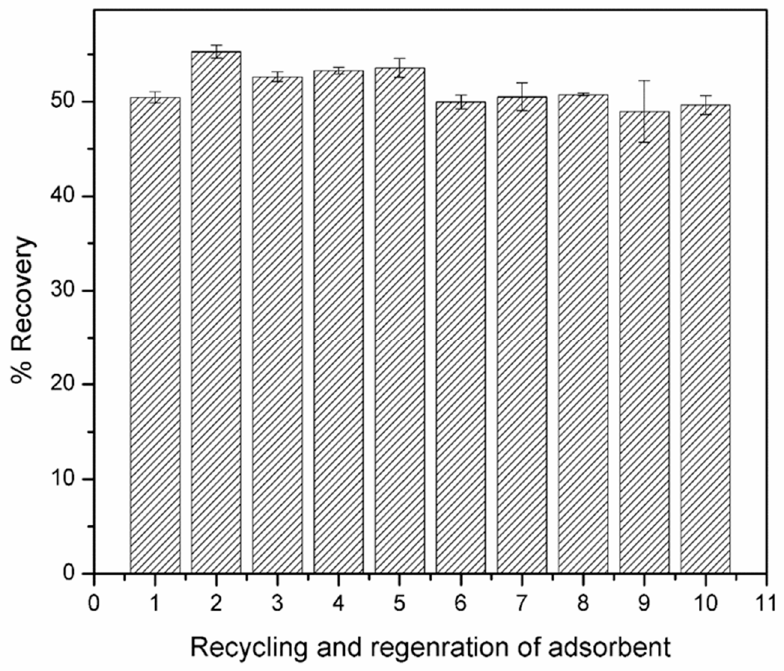
Figure 8. Recovery of Cr (VI) during repeated adsorption of desorption processes. Table 5. Influence of various eluents on the desorption of Cr (VI) ions from the adsorbent. Leaching Solution